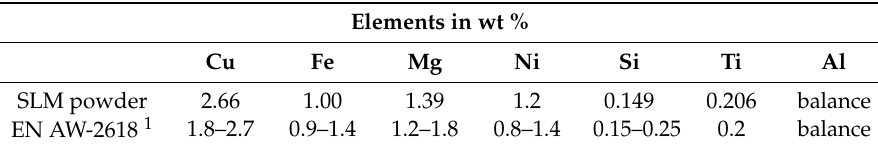
Table 1. Chemical composition of the